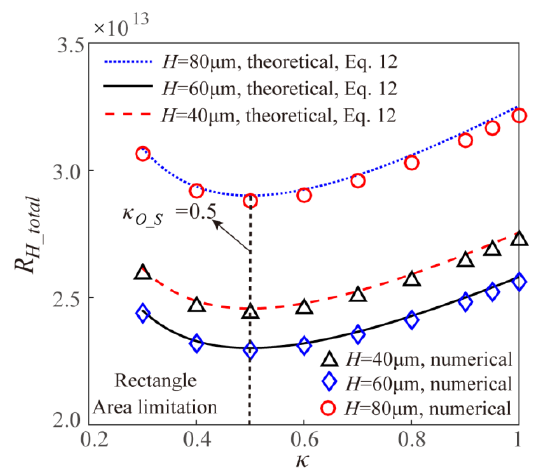
Figure 6. Effect of width ratio κ on the total EOF fluidic resistance in the Y-shaped elemental rectangular microchannel bifurcation with different channel height under the surface area limitation.